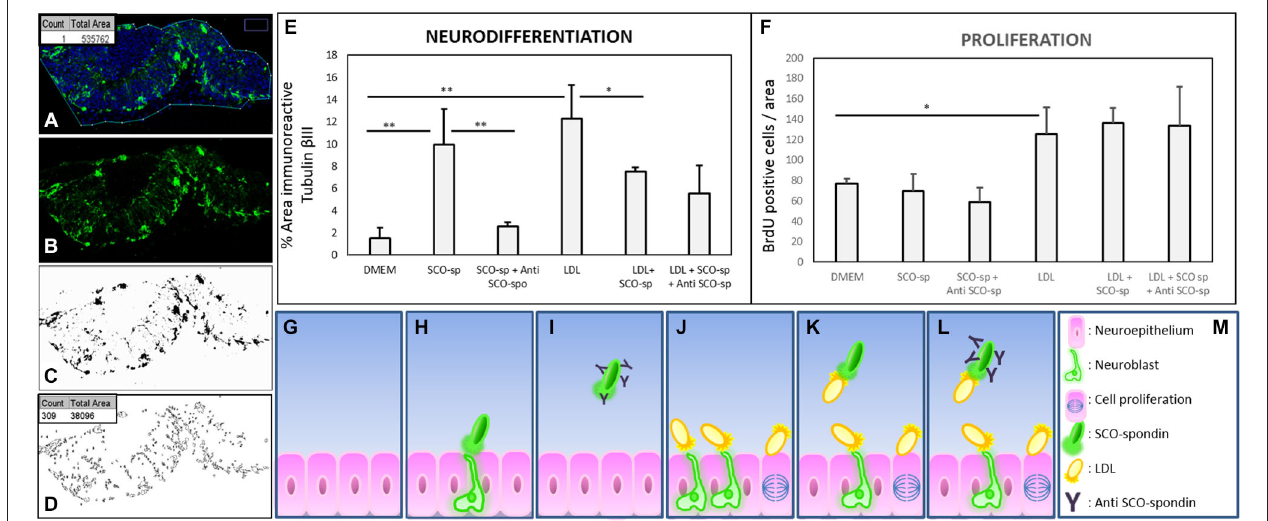
proliferation was measured by the number of BrdU-positive cells per area. (G–M) Scheme showing the interpretation of proliferation and neurodifferentiation analyses. The results showed that SCO-spondin by itself was able to promote the neurodifferentiation of neuroepithelial cells (E,H) , but this capacity drastically diminished in presence of anti-SCO-spondin (E,I) or LDL (E,K) . On the other hand, LDL by itself was able to promote neurodifferentiation (E,J) and proliferation (F,J) . The proliferation generated by LDL was independent of the presence of SCO-spondin and anti-SCO-spondin, but, rather, neurodifferentiation decayed in the presence of SCO-spondin (with or without anti-SCO-spondin), suggesting that the LDL-SCO-spondin complex is unable to promote neurodifferentiation. Statistical analyses were performed using the Student’s t test, * p < 0.05; ** p < 0.01. Bars represent the mean ± SEM of three